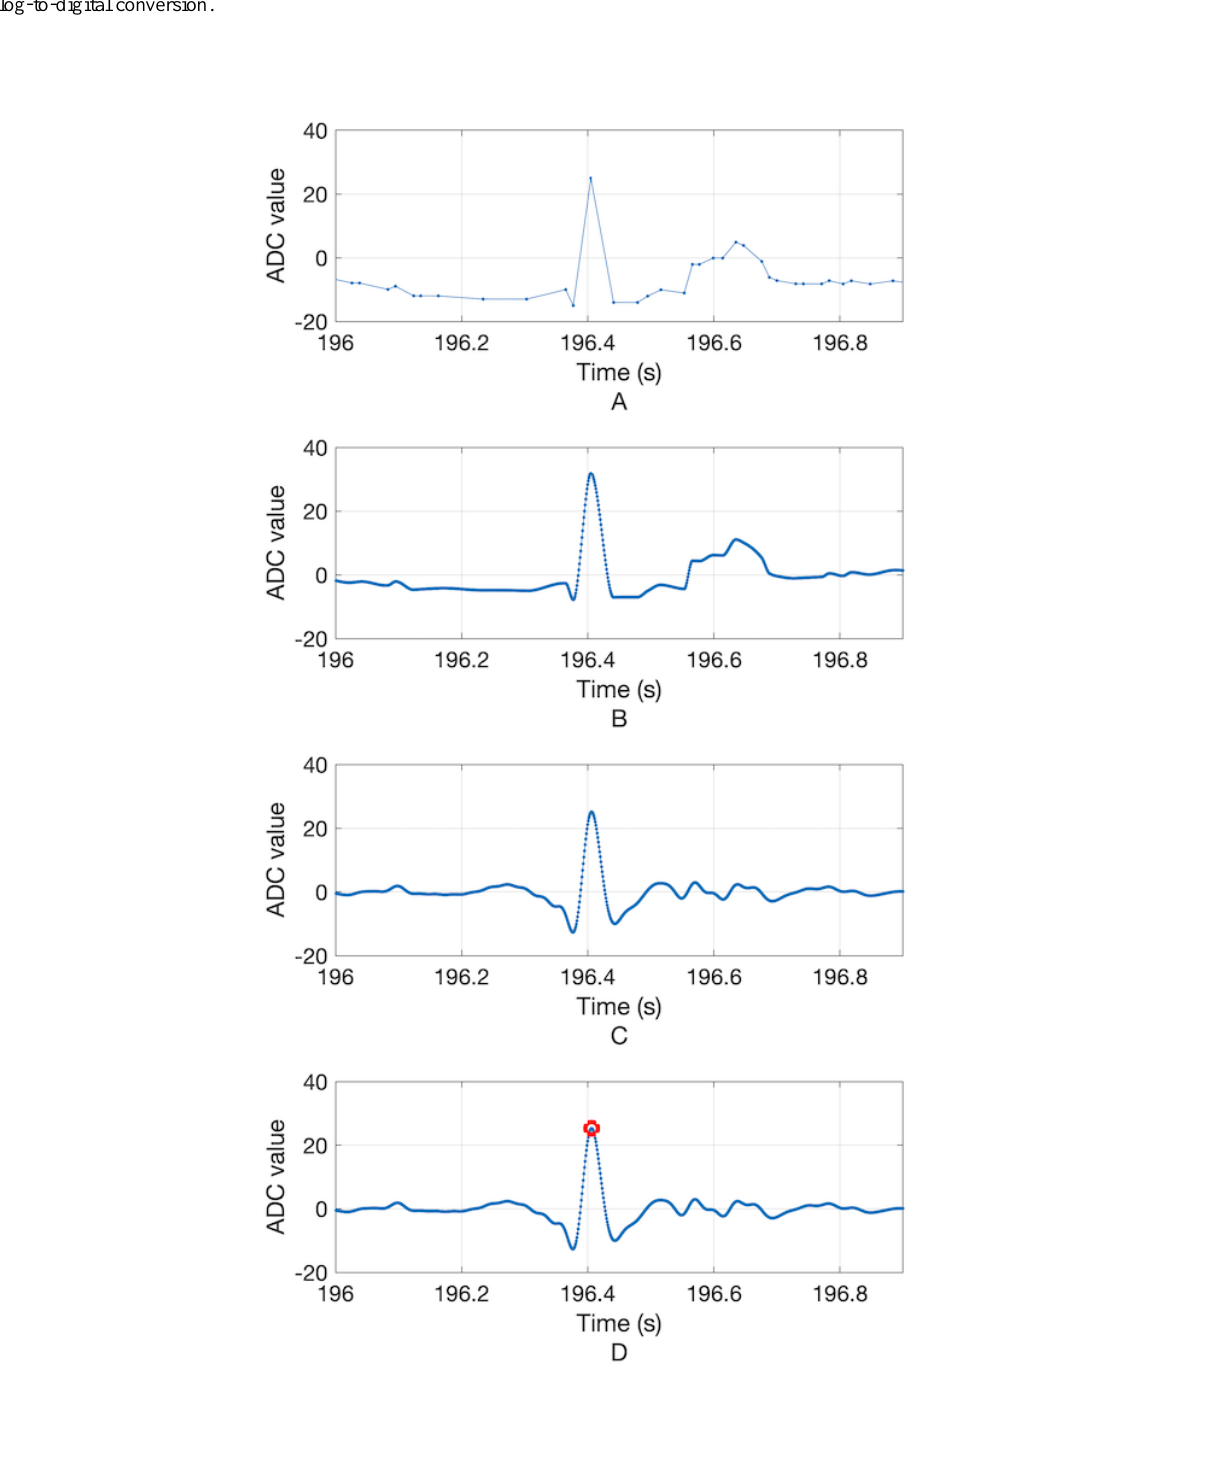
Figure 7. Electrocardiogram waveform modified by signal processing procedure. A. Signal obtained via Bluetooth communication. B. Signal interpolated with 1-kHz sampling frequency. C. Signal filtered with 0.5-35-Hz finite impulse response band-pass filter. D. Detected QRS complex (red circle). ADC: analog-to-digital